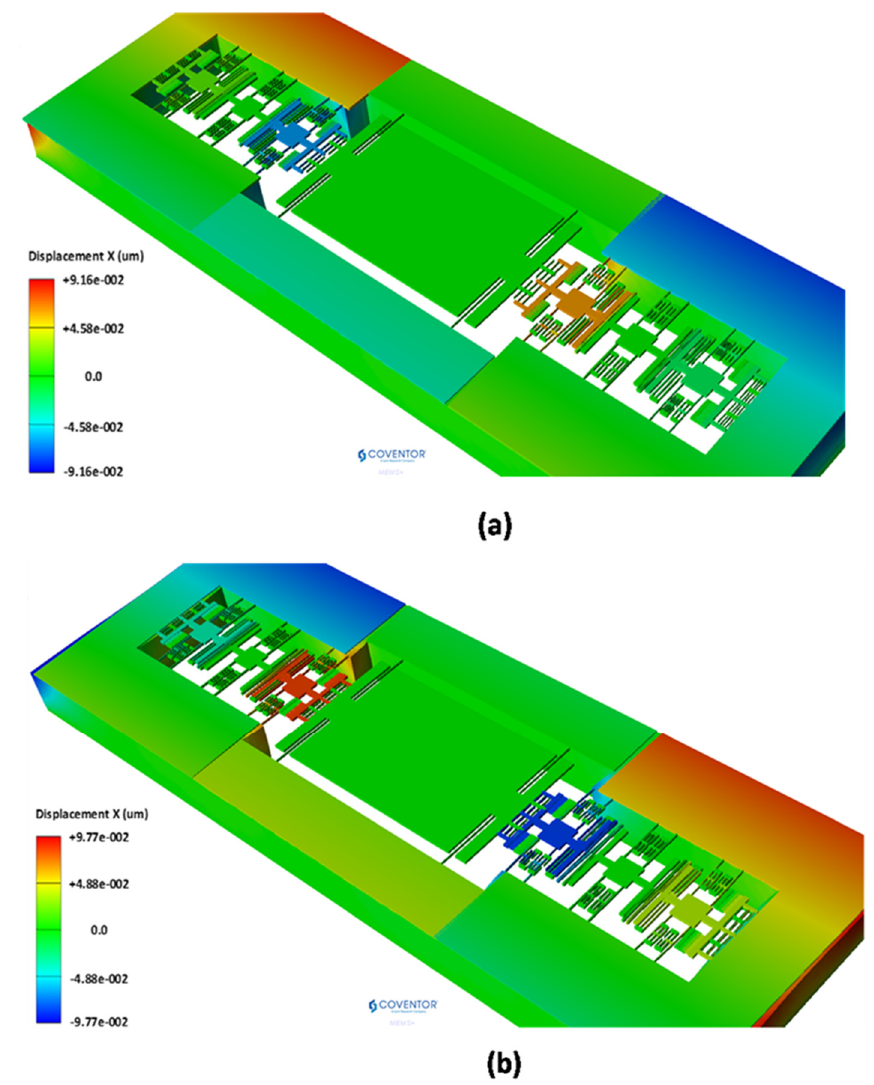
Figure 20. Thermal mechanical deformation profile of the MEMS accelerometer structure at ( a ) − 40 ℃ and ( b ) 85 ℃ . ( a ) − 40 ◦ C and ( b ) 85 ◦